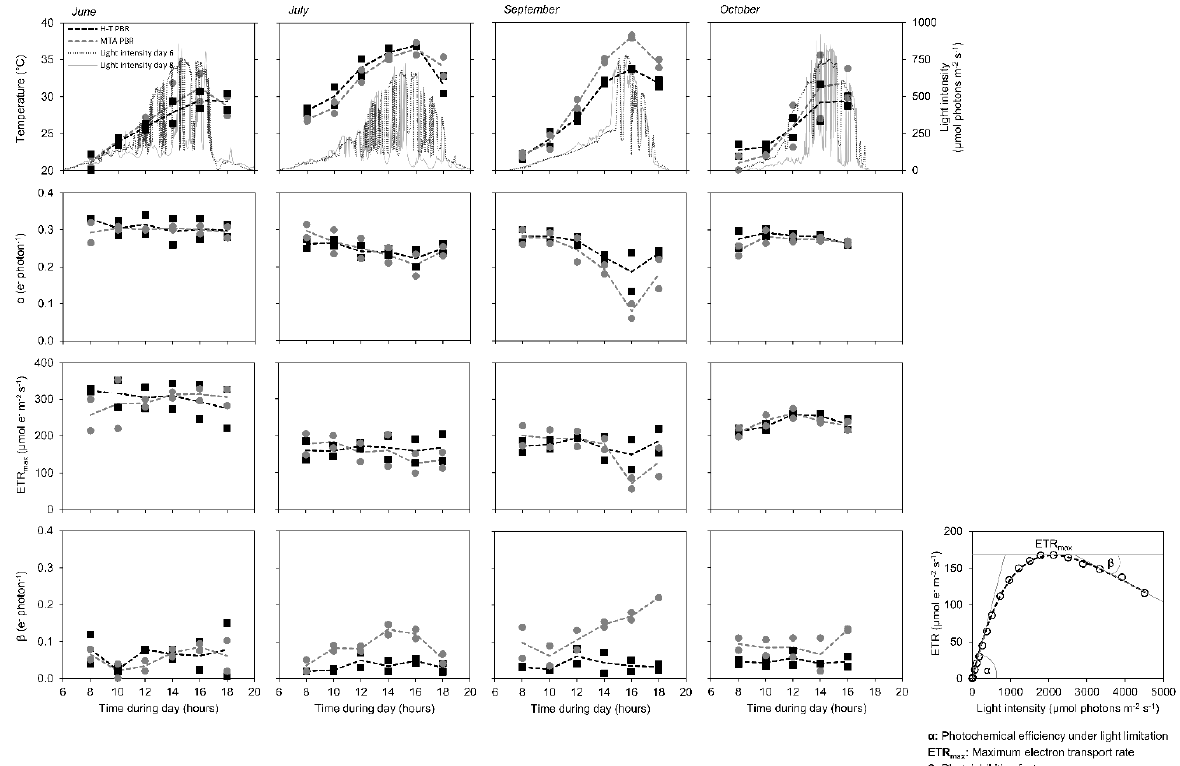
Figure 5. Light intensity and temperature profiles (upper row panels) and photosynthesis efficiency parameters (bottom rows panels) during 6th and 8th day of C. pyrenoidosa cultivation in June, July, September, and October 2018 (left to right columns) in H-T PBR (black lines, black squares) and MTA PBR (grey lines, grey circles). The points represent measured data throughout the light phase of each 6th and 8th cultivation day, the dashed lines represent particular averages. The photosynthesis efficiency parameters, schematically represented in the bottom right panel, were determined according to Equations (4) and (5). All photosynthesis-irradiance curves from which the parameters were derived are summarized in Supplementary Figure S2.